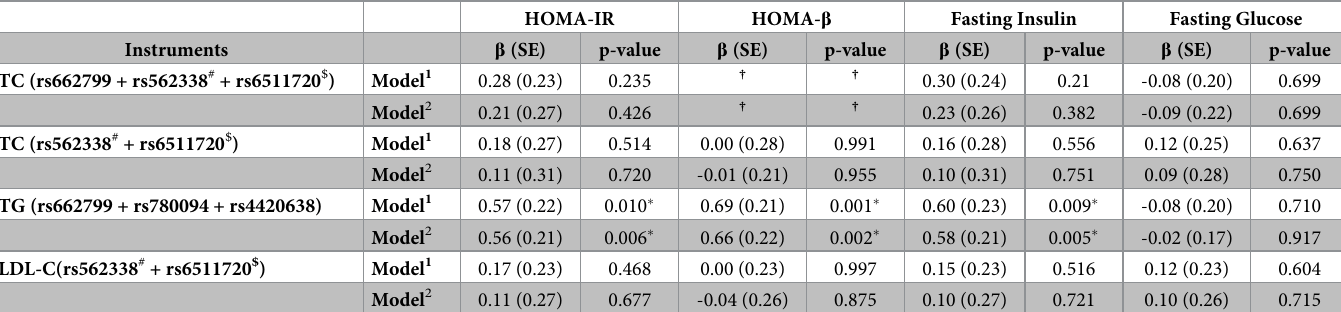
Table 2. Association of lipid traits (explained by instruments) with glycemic traits: Mendelian Randomization